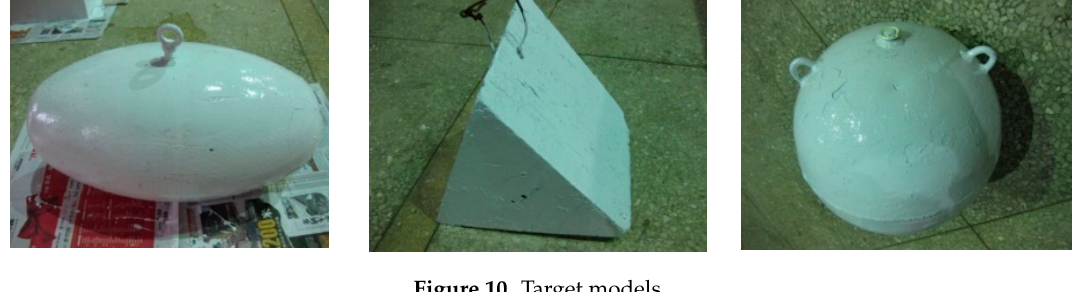
Figure 10. Target models.